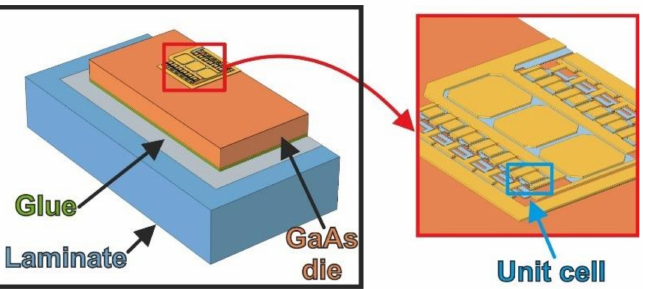
Figure 6. ( Left ) Half of the 24-cell array (with six cells per column) constructed in the COMSOL environment ( draw mode ). ( Right ) Magnification of the die; evidenced is the single unit cell.